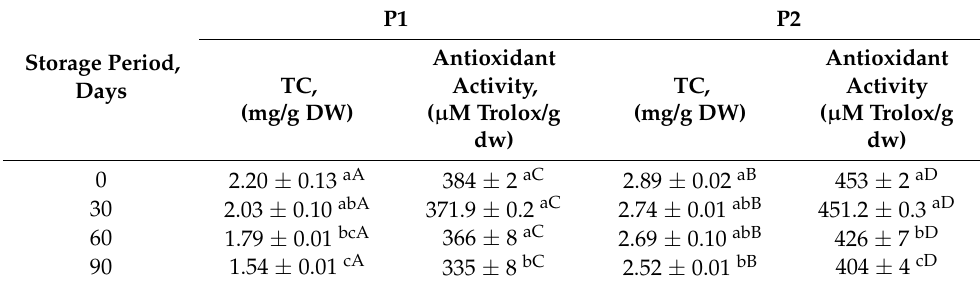
Table 3. Storage stability of phytochemicals from powders.